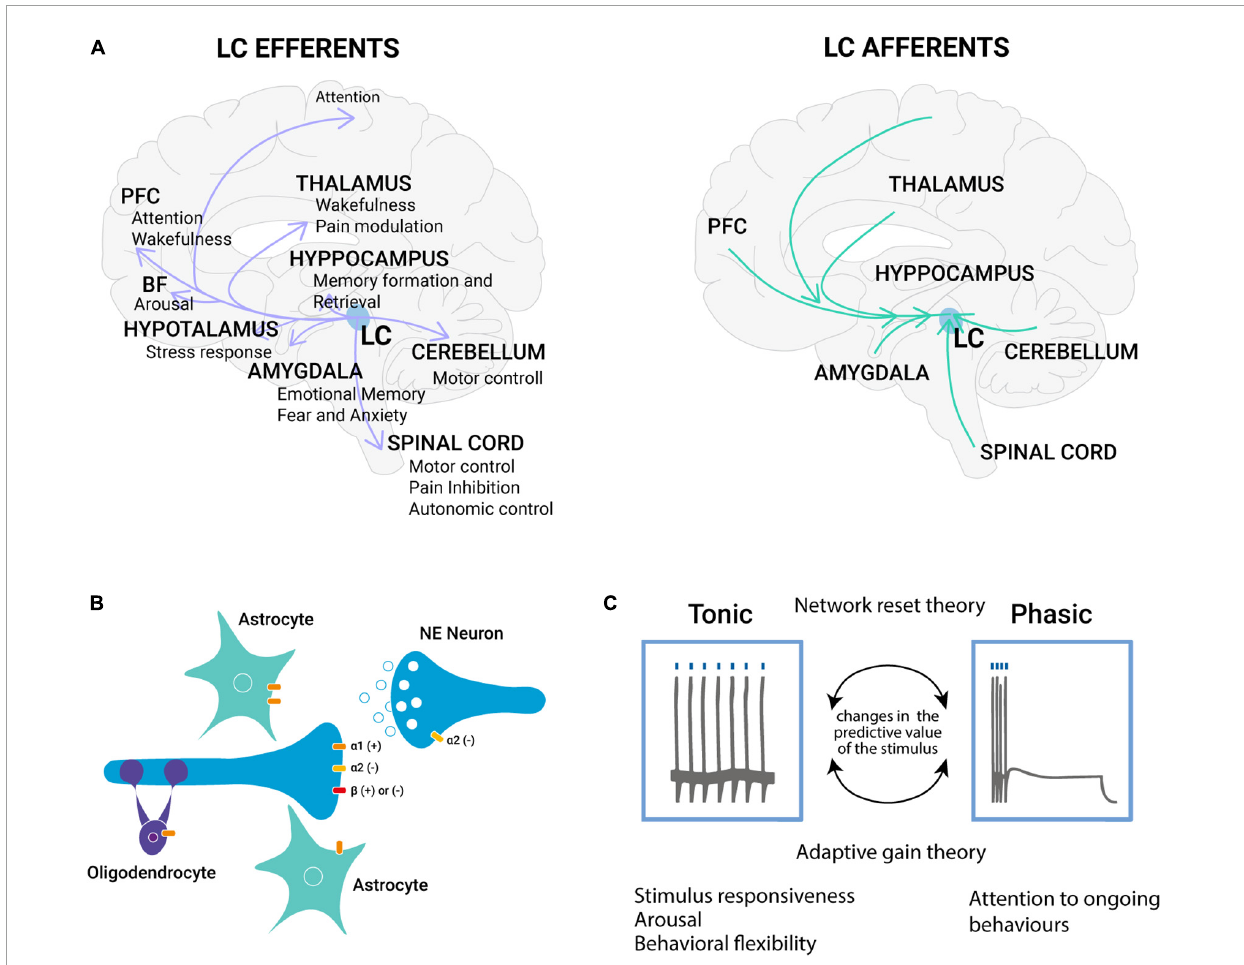
FIGURE1 The noradrenergic system complexity: from molecules to function. (A) LC efferent and afferent projections. The LC is a small bilateral nucleus in the brainstem that widely innervates the brain with broad projections that pervade the cortex. All LC neurons contain NE, thus the LC serves as the primary source of NE in the forebrain. NE released from LC is a ubiquitous neuromodulator that has been linked to multiple functions, including arousal, action sensory gain, and learning (Szabadi, 2013). (B) Diffuse hormone-like action of NE release. NE α 1- and β -receptors are thought to exist primarily post-synaptically (heteroreceptors), whereas α 2-receptors are present both pre- (autoreceptors) and post-synaptically (Szabadi and Bradshaw, 1991). The autoreceptors of the α 2 sub-class are inhibitory in action and are involved in the inhibition of neuronal firing (Bertolino et al., 1997; Huang et al., 2012) or NE release (Starke, 2001) based on their location. α 1-receptors are mainly excitatory, while β -receptors are excitatory or inhibitory (Szabadi, 2013). In the CNS, adrenergic heteroreceptors have been identified on the terminals of serotonergic (Haj-Dahmane and